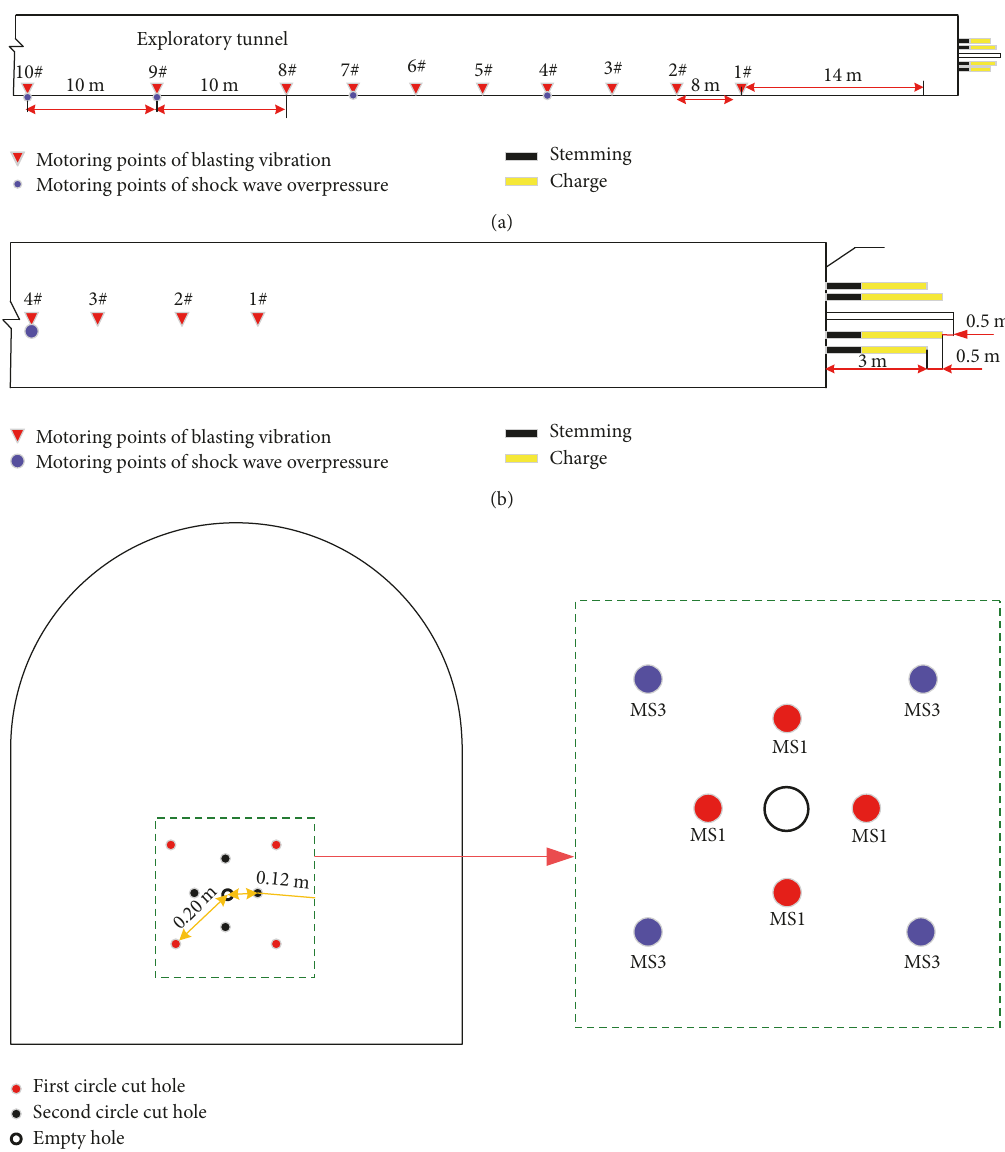
Figure 2: Design sketch of blasting experiment: (a) distribution of monitoring points in longitudinal direction, (b) distribution of monitoring points in horizontal direction, and (c) cut holes arrangement in the position of tunnel